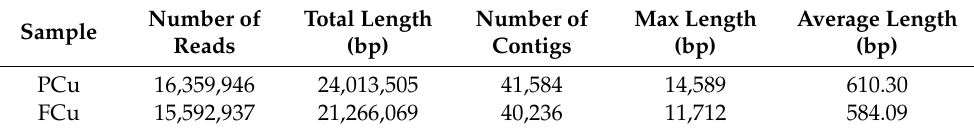
Table 1. Summary of the de novo assembly of transcriptomic profiles of C. uncinata